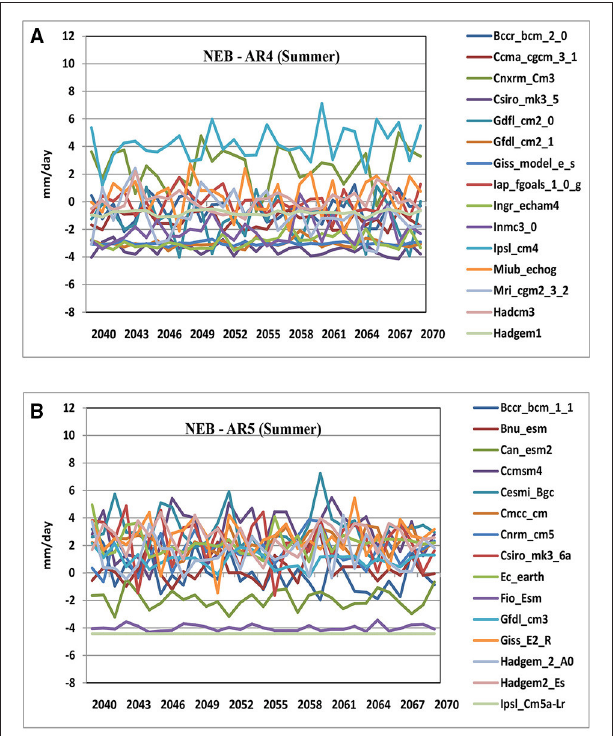
FIGURE 9 | Summer rainfall anomalies projected for semiarid region of NNB from CMIP3-AR4 (A) and CMIP5-AR4 (B) models over the period